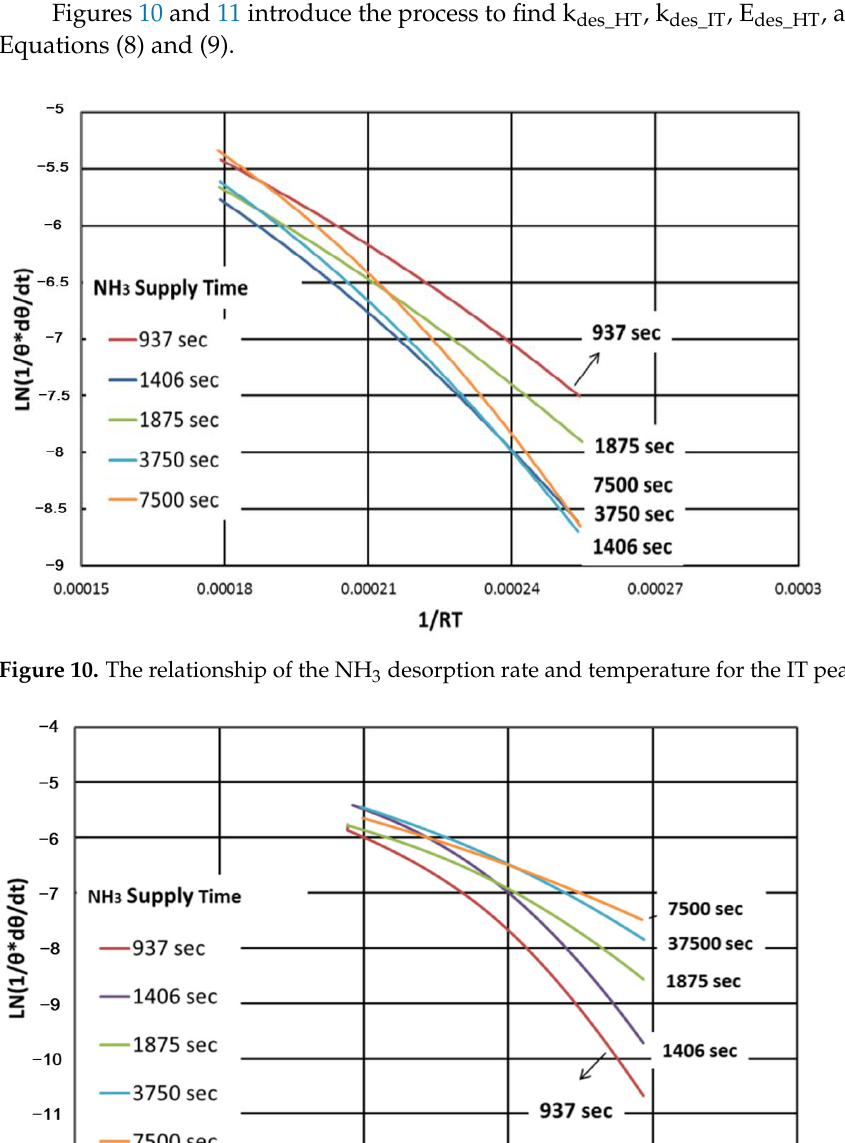
Figure 11. The relationship of the NH 3 desorption rate and temperature for the HT peak.